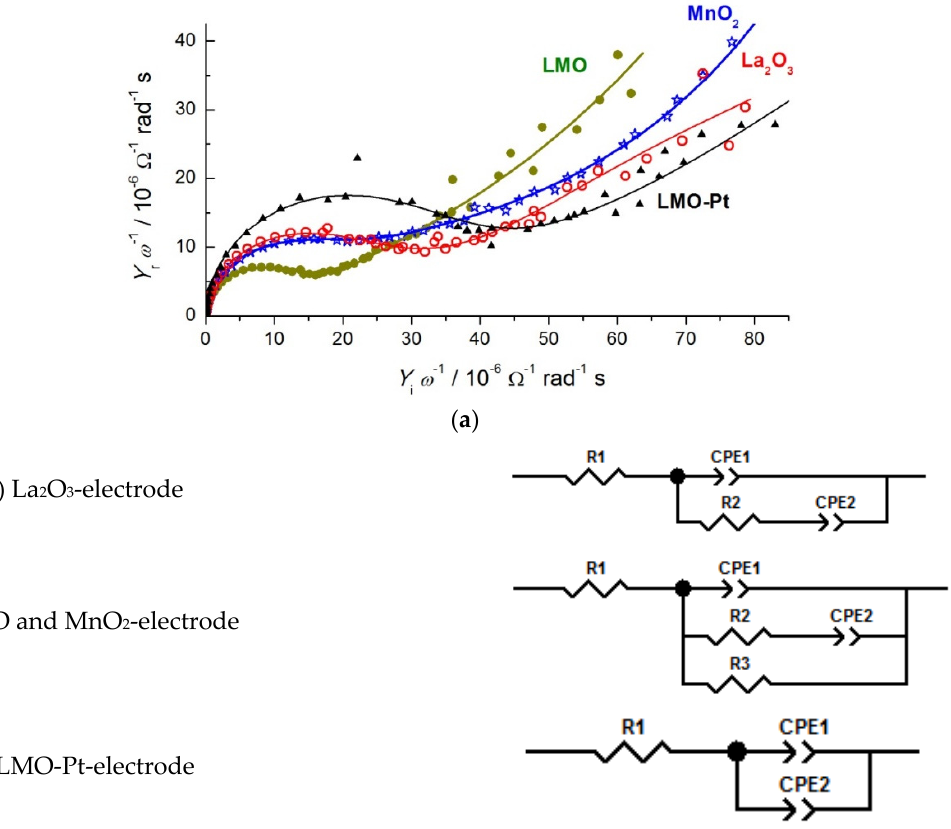
Figure 4. ( a ) Capacitance complex plane plots for synthesized materials at OCP in 0.10 M KOH and ( b – d ) equivalent circuits used to fit the experimental EIS data. Equivalent electric circuit data are presented by lines in the plots.